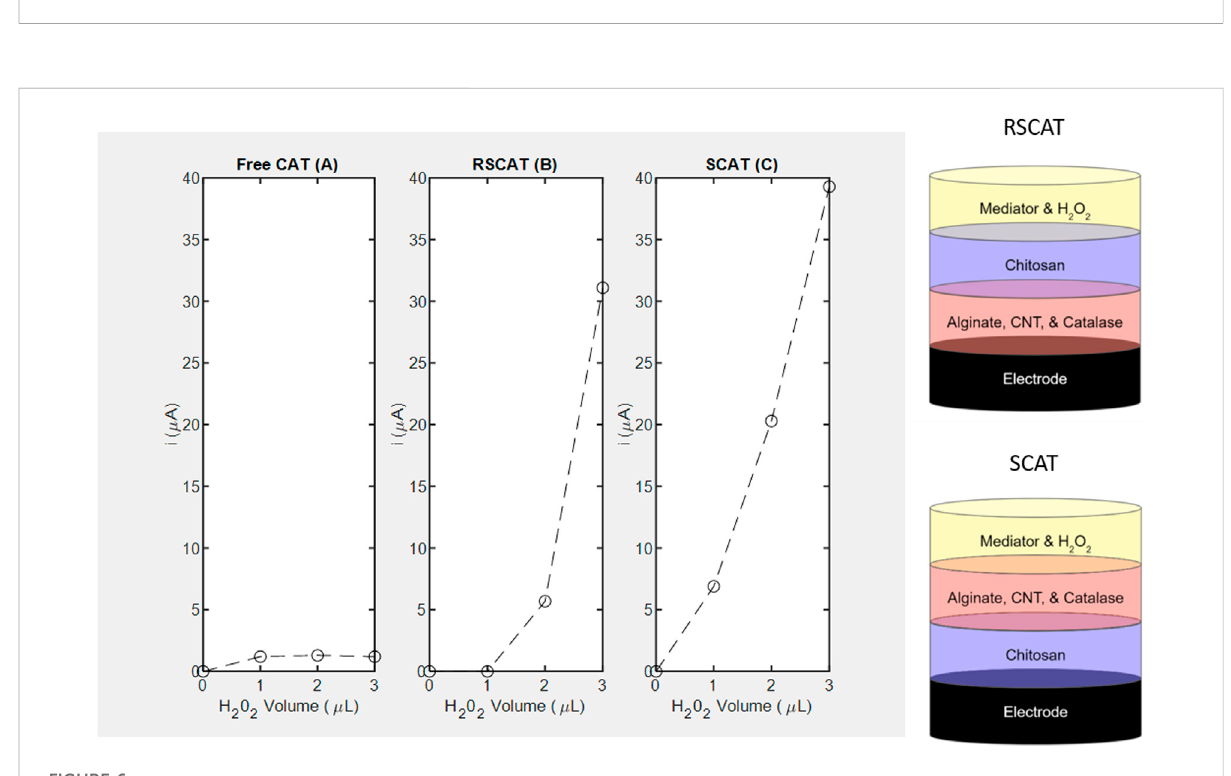
FIGURE 6 Amperometric studies of catalase measured at -0.4 V using H 2 O 2 as substrate and corresponding layer stacking con fi gurations (not drawn to scale). (A) Free enzyme denoted as FreeCAT; (B) RSCAT nanocomposite fi lm where chitosan is not in contact with the SPCE; (C) SCAT nanocomposite fi lm where chitosan is in contact with the